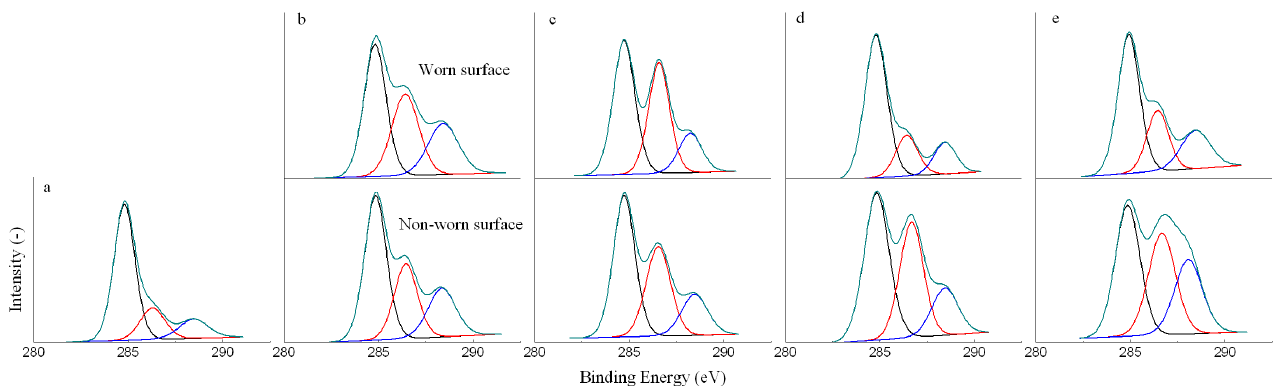
Figure 3. Deconvoluted C 1s XPS spectra of the untreated new ball ( a ) and balls lubricated with EO10 ( b ), EO30 ( c ), EO50 ( d ) and BO ( e ) under 392 N.